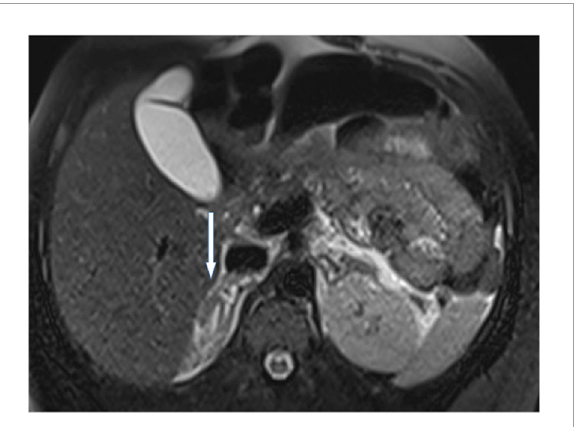
FIGURE2 A representative image of adrenal glands with magnetic resonance imaging. T2 axial view at time 0 confirmed enlarged adrenal glands with hyperintense signal due to hyperacute hemorrhage. No focal lesions were described.